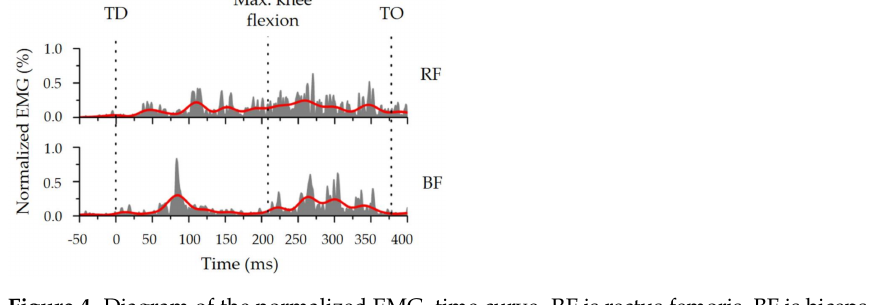
Figure 4. Diagram of the normalized EMG–time curve. RF is rectus femoris, BF is biceps femoris, TD is touchdown, and TO is